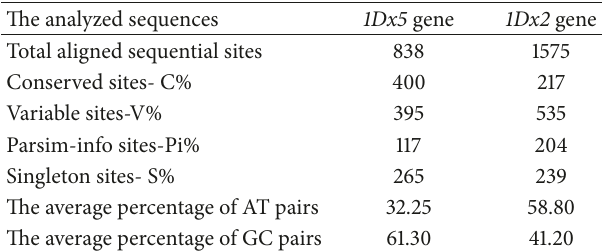
Table5:ComparisonofthenucleotidecompositionofDNAregions in 1Dx5 and 1Dx2 genes of the analyzed wheat